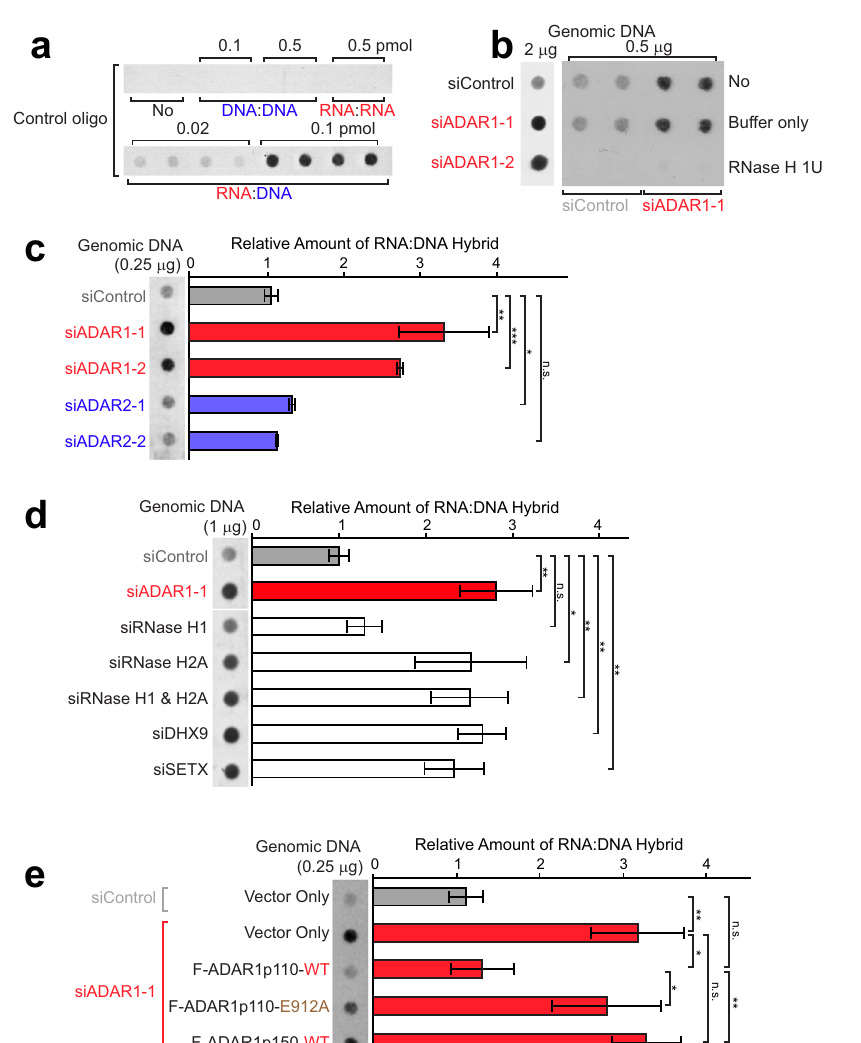
Fig. 1 ADAR1 depletion resulted in abnormalities of the nucleus and upregulation of DNA damage pathway and cell cycle marker genes. a HeLa cells were fi rst transfected with siControl or siADAR1 (siADAR1-1) for 72 h and then treated with CellLight Tubulin-GFP. Nuclei were visualized by staining of DNA with SiR-DNA reagent. Representative images taken from real-time videos (Supplementary Movies S1 and 2) are presented. Scale bar, 50 μ m. b The frequency of abnormalities of the nucleus (nucleoplasmic bridge, micronuclei, and multinuclei) was estimated by examining at least 200 individual HeLa cells treated with siControl or siADAR1-1 RNAs. Values are mean ± standard error ( n = 3, biologically independent samples) with signi fi cant differences by